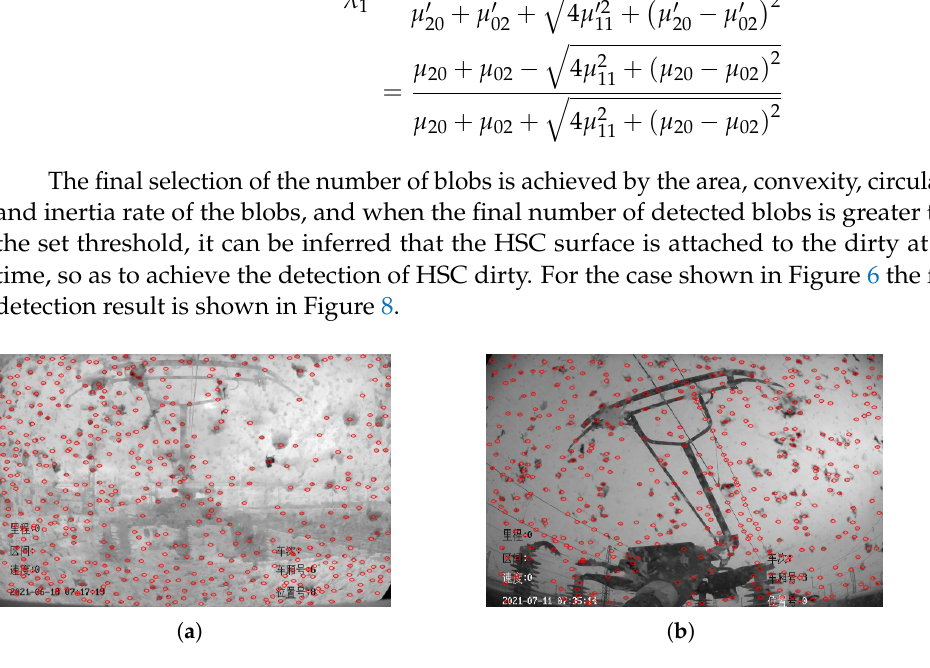
Figure 8. The HSC Screen dirty detection results. ( a ) HSR-A. ( b )